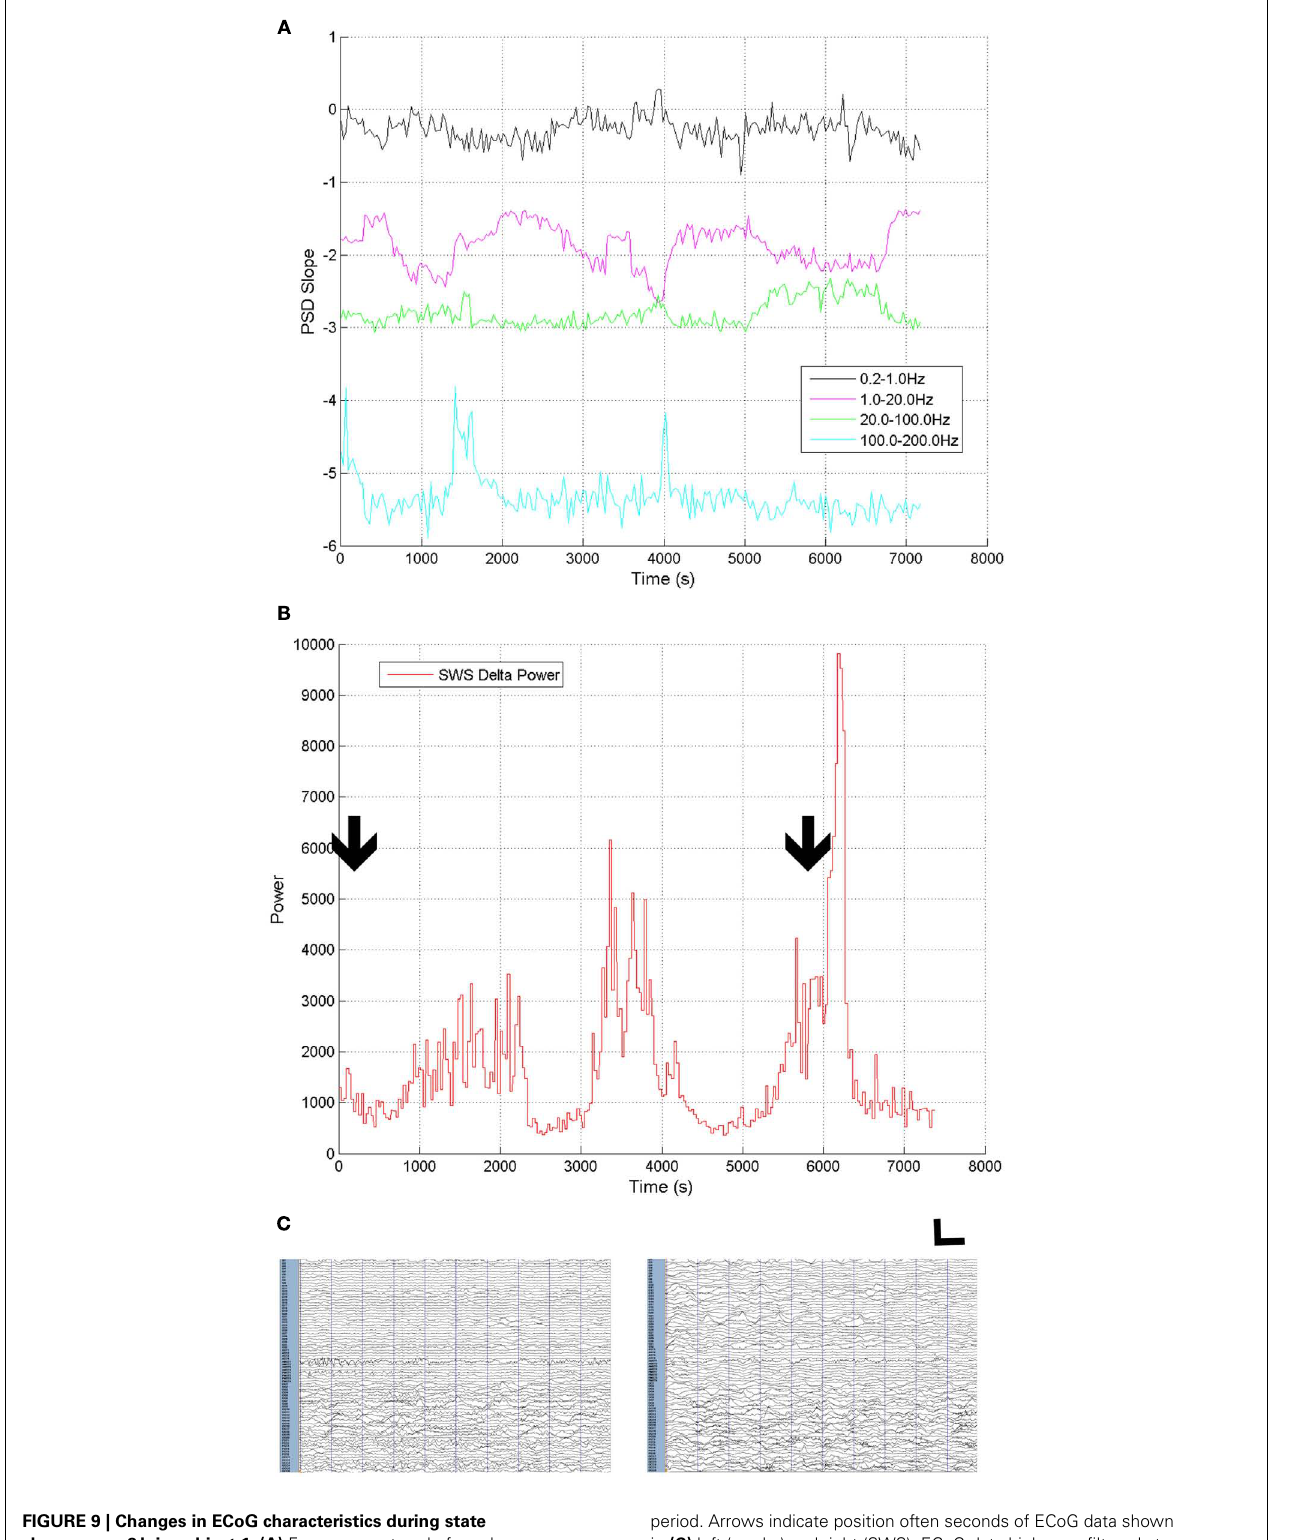
FIGURE 9 | Changes in ECoG characteristics during state change over 2h in subject 1. (A) Four segment scale-free slopes calculated with prespecified frequency ranges. (B) Delta and up-down frequency range power (0.5–4Hz) over the same time